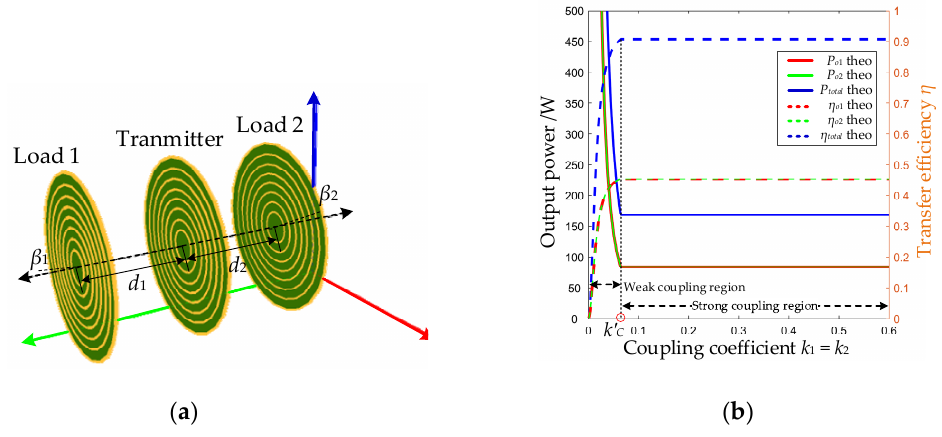
Figure 7. Schematic diagram of power distribution when k 1 = k 2 : ( a ) loads position; ( b ) output power and transfer efficiency of system and each load. (In the figure, “theo” is the abbreviation of “theory”, which represents the theoretical value, the same below.)